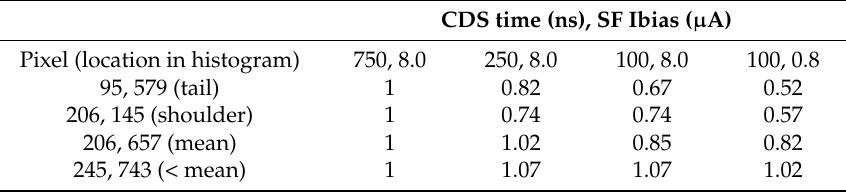
Table 4. Normalized total noise for selected pixels vs. t CDS (ns) and SF Ibias ( µ A).